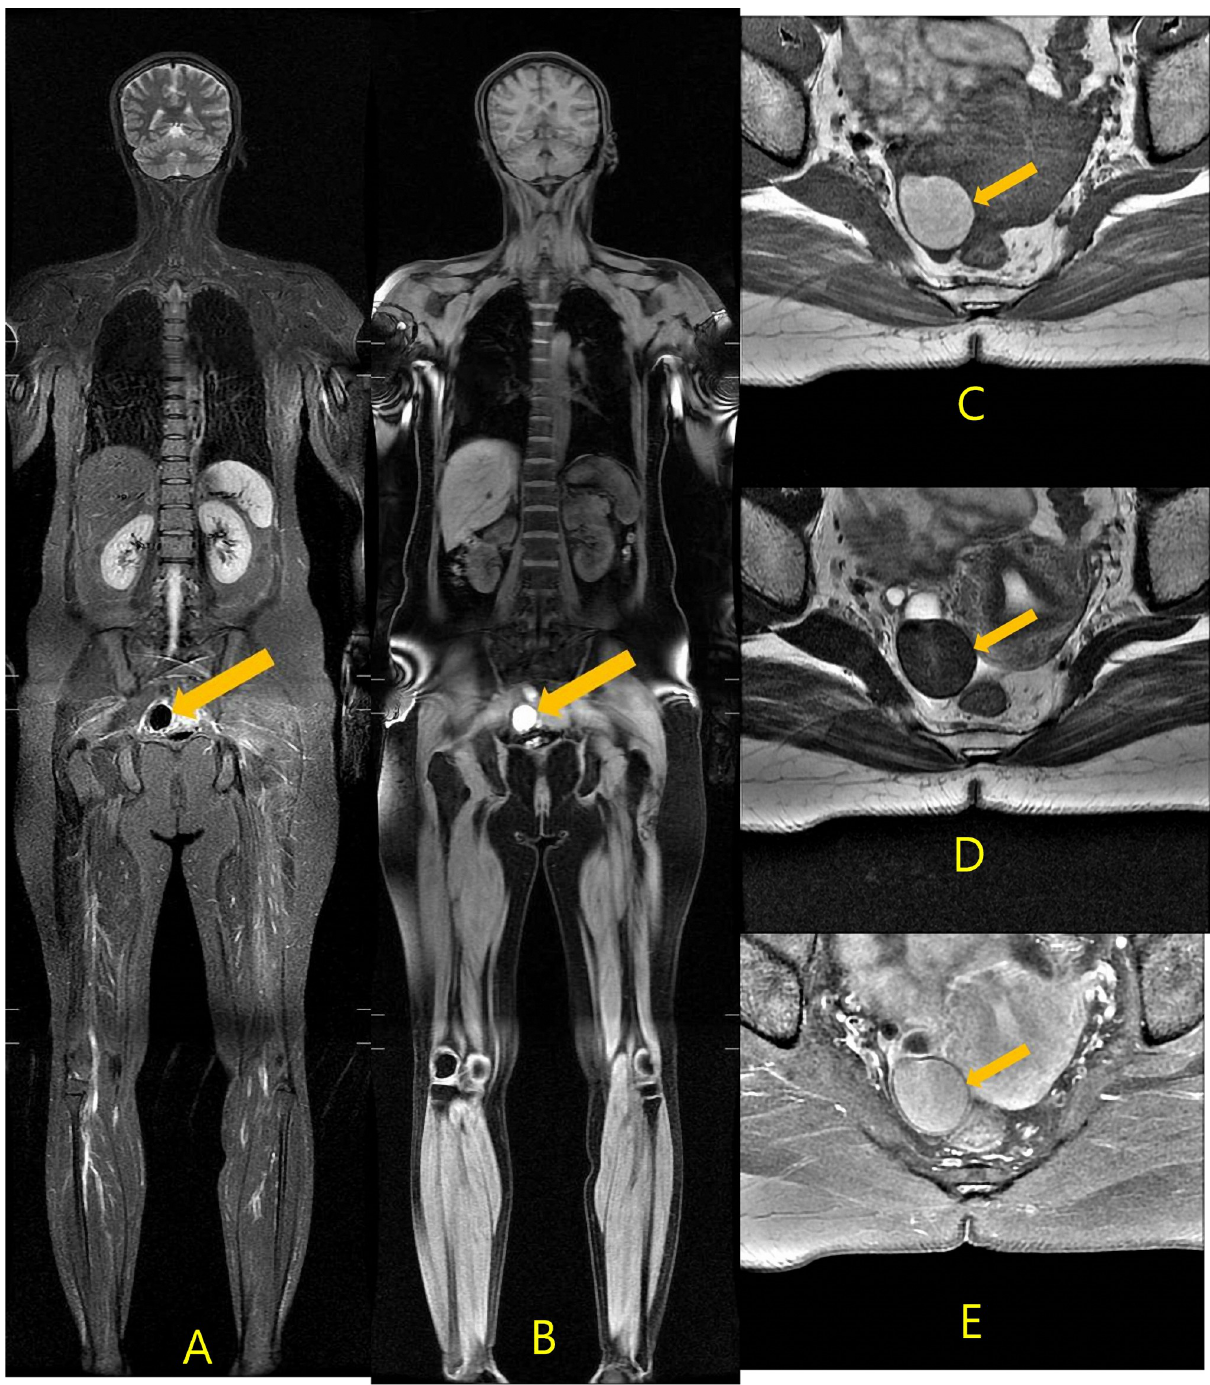
Fig 2. A 43-year-old woman who underwent a routine health examination. Coronal T 2 -weighted STIR image (TR/TE, 6000, 2800/35, A) and coronal T 1 fat suppression SPGR (TR/TE, 7.6, 6.3/3.6, B) images revealed a well-defined, 3-cm hemorrhagic mass in the pelvic cavity (arrow). The initial radiologic diagnosis was endometrioma. Radiologist reviewers classified this lesion as category II. The follow-up axial MRI, including T 1 -weighted MR image (TR/TE, 600/9, C), T 2 -weighted MR image (TR/TE, 3700/100, D) and fat-saturated enhanced T 1 -weighted MR image (TR/TE, 800/10, E), revealed a 3-cm well-defined oval shaped mass at the right adnexa suggestive of an endometrial cyst (arrow).